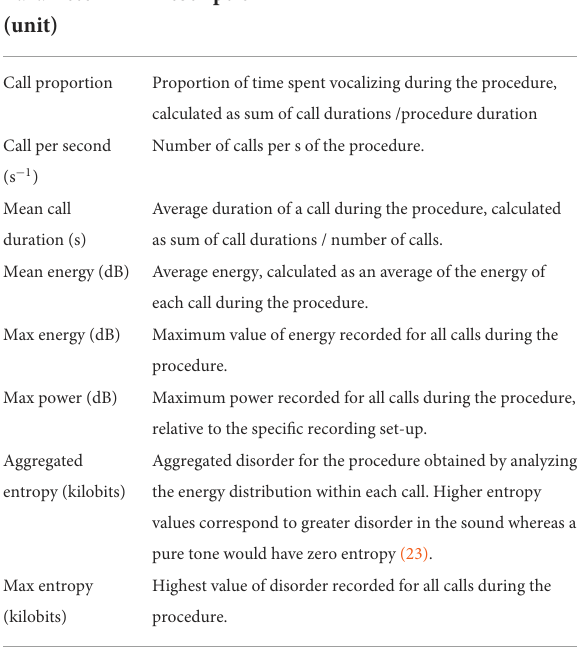
TABLE 2 Description of the vocal parameters analyzed for each piglet during injection of local anesthetic, castration, or sham handling while in the castration